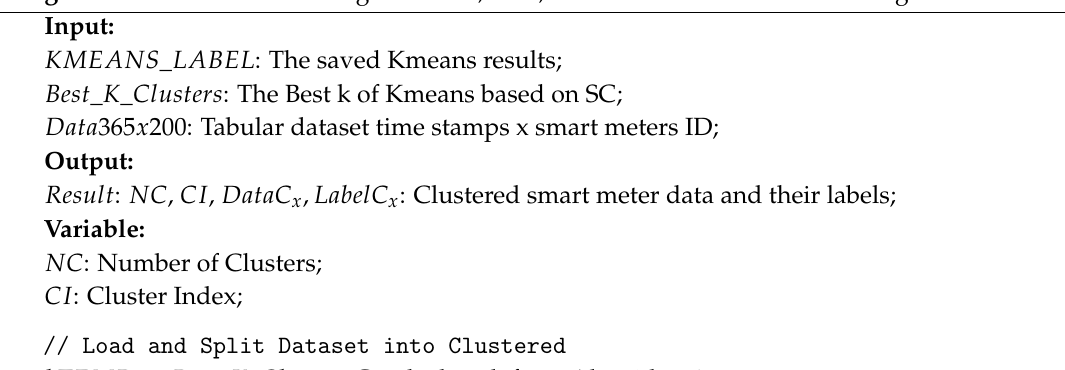
Algorithm 2 Kmeans: Choosing members, data, and labels of Kmeans Clustering.